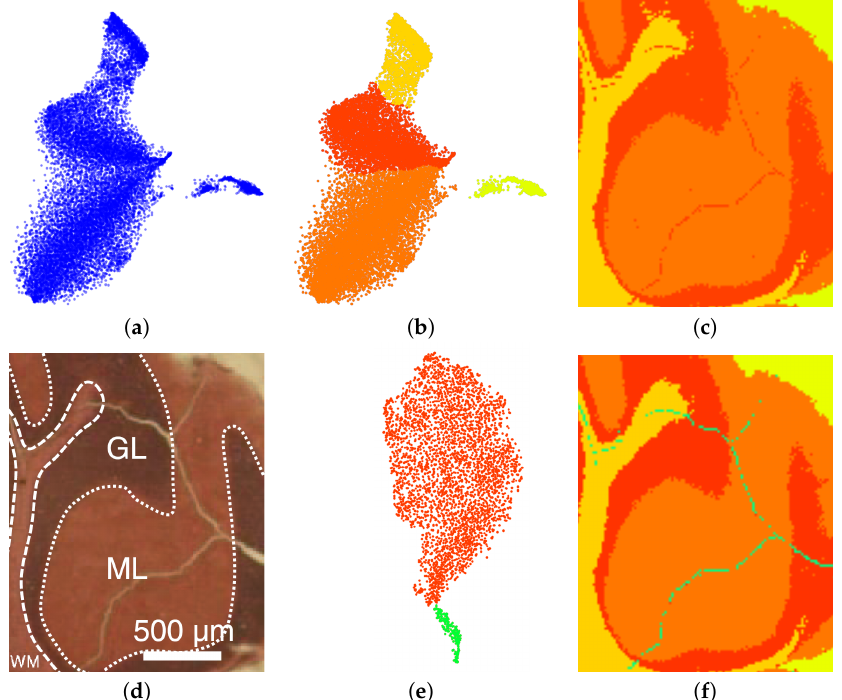
Figure 12. Mouse cerebellum in positive ion mode data set [9]: Non-linear embedding of spectral information ( a ) and interactive selection of clusters in the non-linear embedding ( b ) reveals image regions ( c ) close to ground truth ( d ). Selecting the red cluster in ( b ) for generating a non-linear embedding of the sub-population ( e ) allows for a refined and improved result ( f